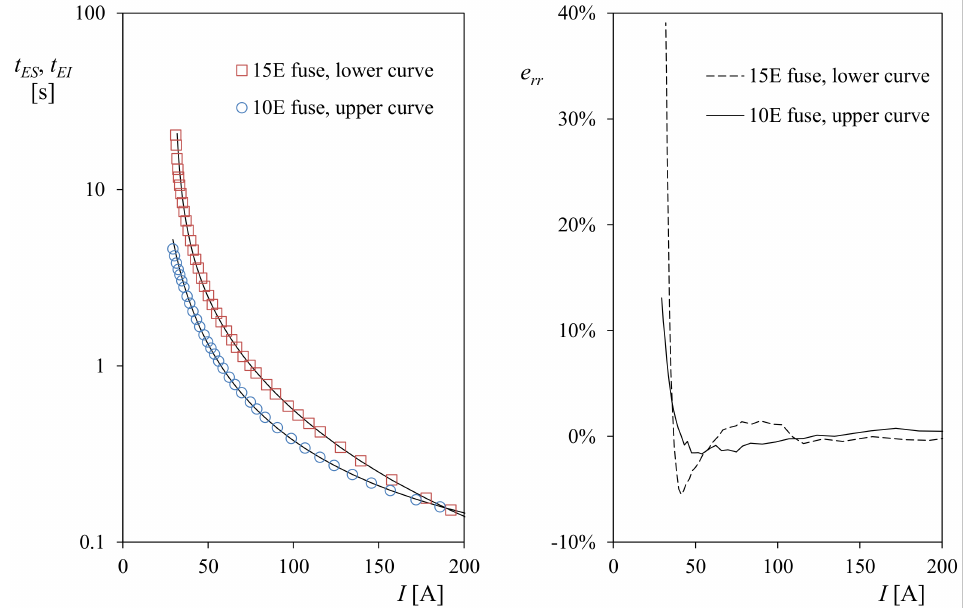
Figure 5. (Left) SMD-50 10E fuse upper curve and SMD-50 15E fuse lower curve from the manufac- turer’s data. Equations (6) and (7) have been fitted to these data (solid lines). (Right) Error, e rr , of the proposed fuse model with regard to the manufacturer’s data.